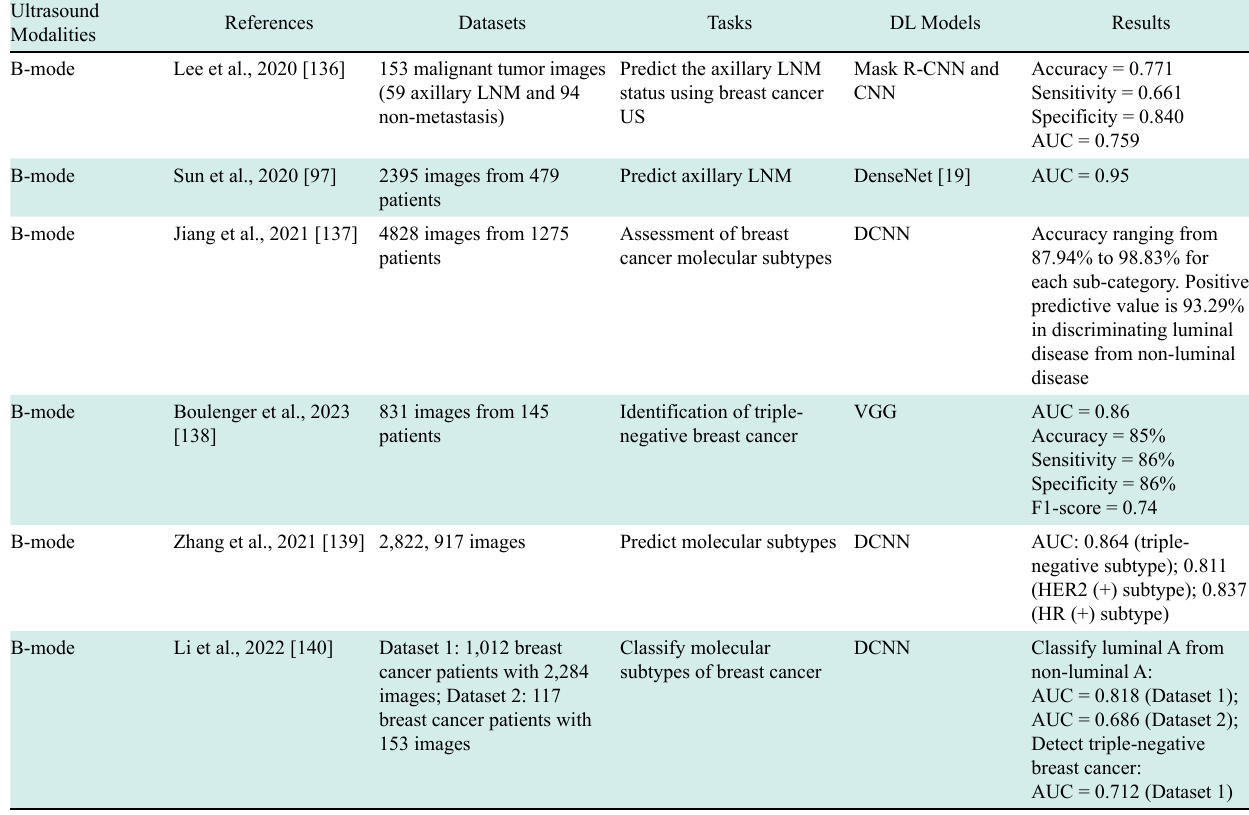
Table 3 Deep learning for breast cancer diagnosis in